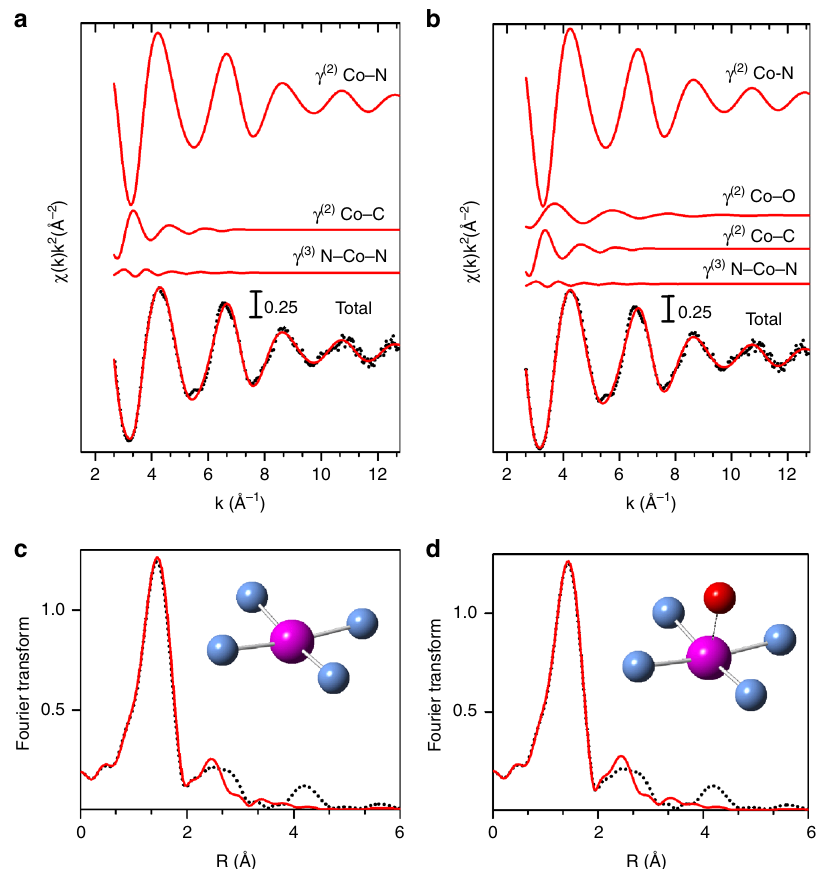
Fig. 1 Co K-edge EXAFS analysis. Spectra of Co 0.5 with a CoN 4 moiety having zero (left) or one (right) oxygen atom in the axial direction. Cobalt, nitrogen and oxygen atoms are represented in purple, blue and red, respectively (carbon atoms in the second coordination sphere are not represented). a , b Curves from top to bottom: Co – N, Co – O and Co – C γ (2) two-body signals and the N-Co-N γ (3) three-body signal included in the fi t, the total signal (red line) superimposed on the experimental one (black dots). c , d the fi t in the Fourier-transformed space. No phase-shift correction was applied to the Fourier